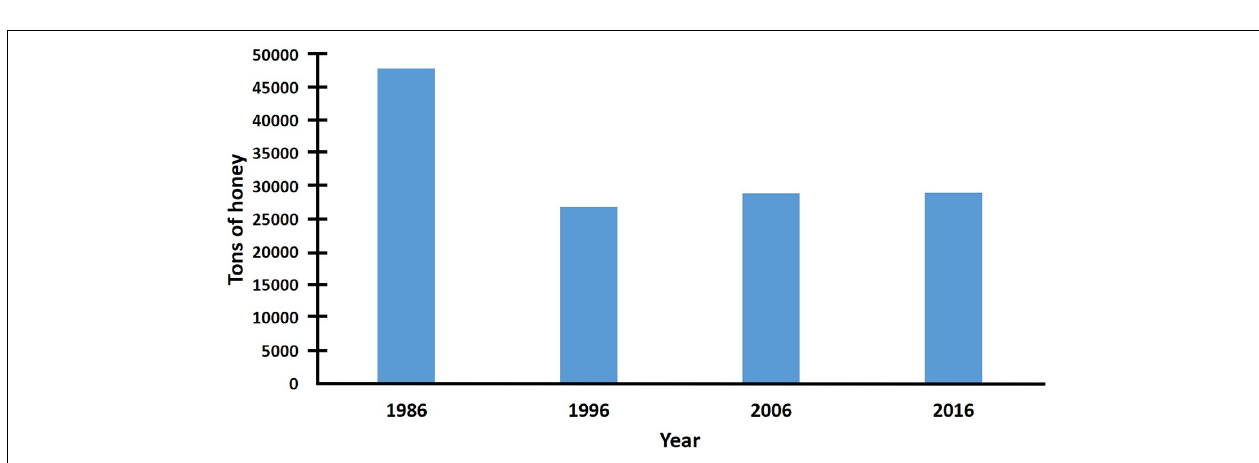
FIGURE 4 | Honey exports in Mexico the year of the arrival of AHBs (1986), 10 (1996), 20 (2006), and 30 (2016) years later (data from Sader, 2020).